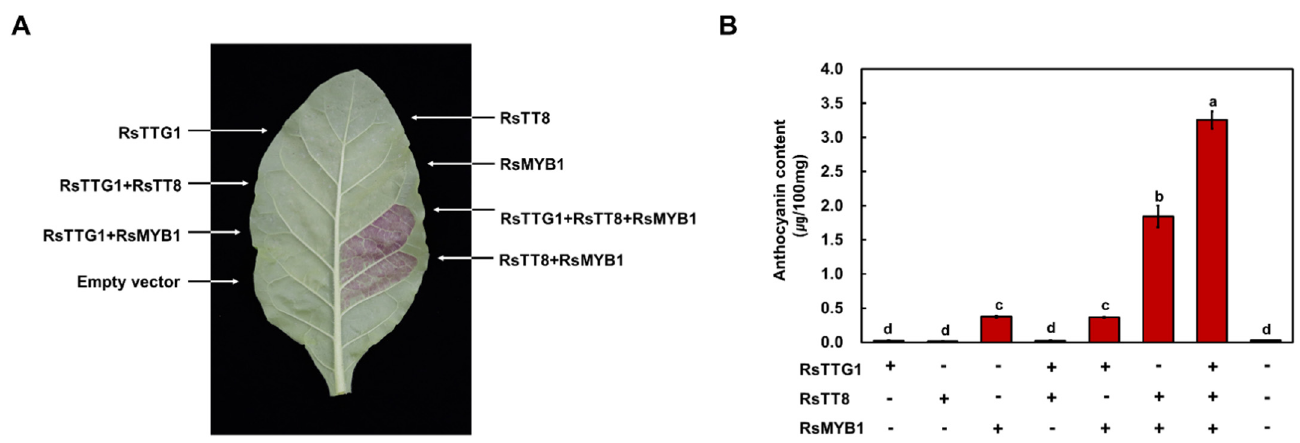
Figure 7. Functional analysis of RsTTG1, as a member of an MBW complex for anthocyanin biosyn- thesis. Visual phenotype and anthocyanin contents of tobacco leaves transiently infiltrated with Agrobacterium strains harboring an empty vector or constructs containing RsTTG1, RsTT8, and/or RsMYB1 in the indicated combinations. ( A ) Representative photograph of a transiently infiltrated tobacco leaf at 5 days after agroinfiltration. ( B ) Anthocyanin contents of the leaf sections shown in ( A ). Results are the means ± SD from three independent biological replicates. Different letters indicate significantly different values ( p < 0.05), as determined using one-way ANOVA followed by Duncan’s multiple range tests.